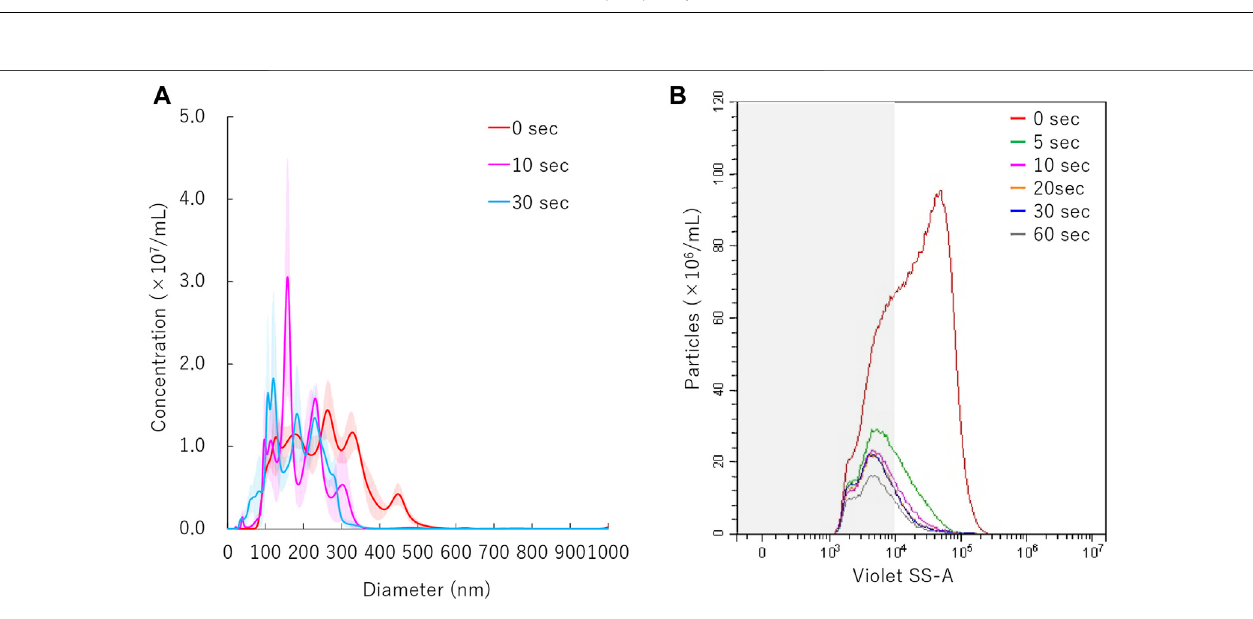
FIGURE 5 | Nanobubbles size distribution with various sonication duration. (A) Size distribution of nanobubbles (NTA) with or without sonication. (B) The concentrations and size distribution of nanobubbles with or without sonication (FCM). Gray shaded area indicates nanobubbles size less 200 nm.